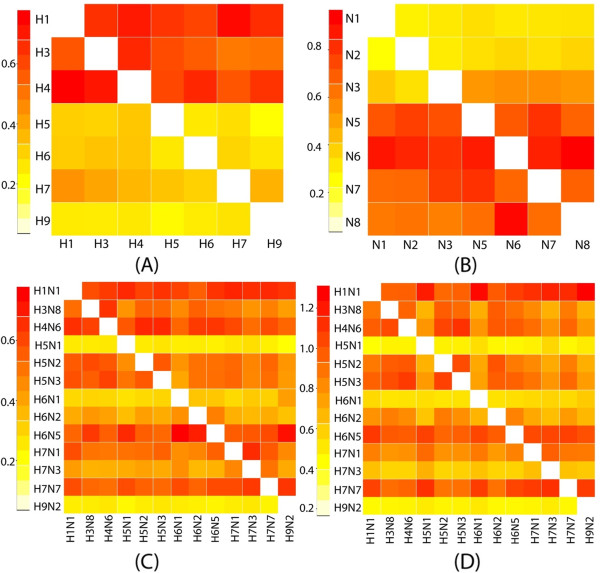
Reassortment rates between internal segments of different subtypes. A: PB2 segments associated with HA subtypes shown, which means PB2 that are associated with H1, H3 and H4 subtypes rapidly reassort to become associated with any HA, while PB2 associated with H5, H6, H7 and H9 subtypes reassort more slowly to become associated with any HA. B: PB2 segments associated with NA subtypes shown; C: PB2 segments associated with combined HA- NA subtypes shown; D: NS segments associated with combined HA- NA subtypes shown. Reassortment rates are shown as a heat map. Both forward and reverse rates are shown, with subtypes labeled on the left side acting as donors and subtypes labeled at the bottom acting as recipients. The values of the mean reassortment rates, in exchanges per year, are represented as colors from yellow (low) to red (high). The scale of rates is on the left hand side of each plot.